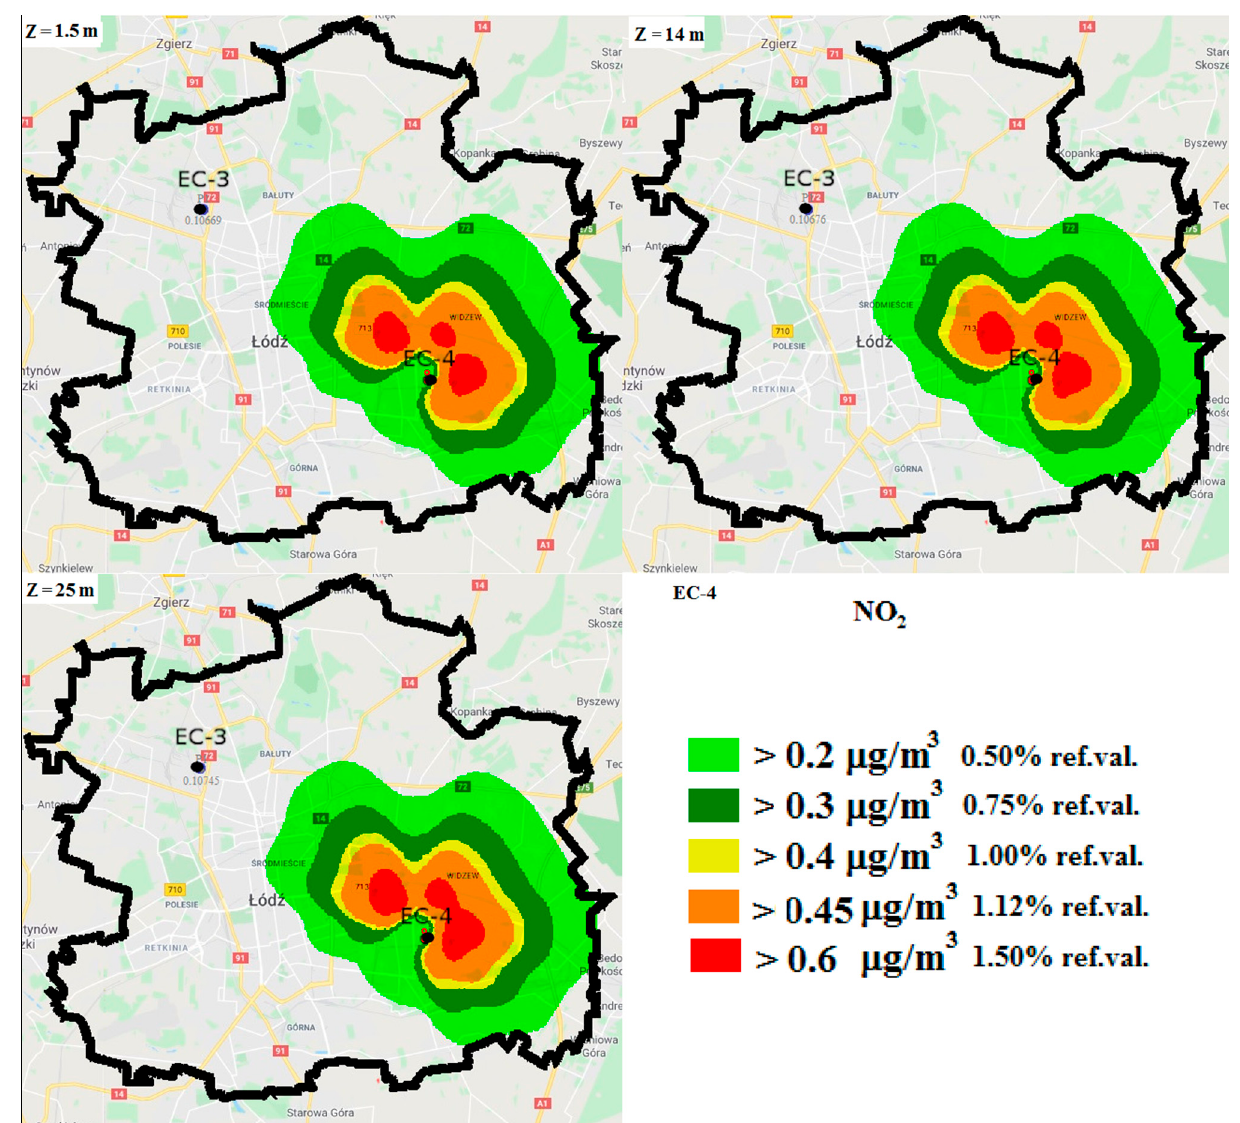
Figure 9. Distribution of annual average NO 2 concentrations at the height of 1.5 m, 14 m, and 25 m surrounded by EC-4 in 2019 based on the results from OPA03.